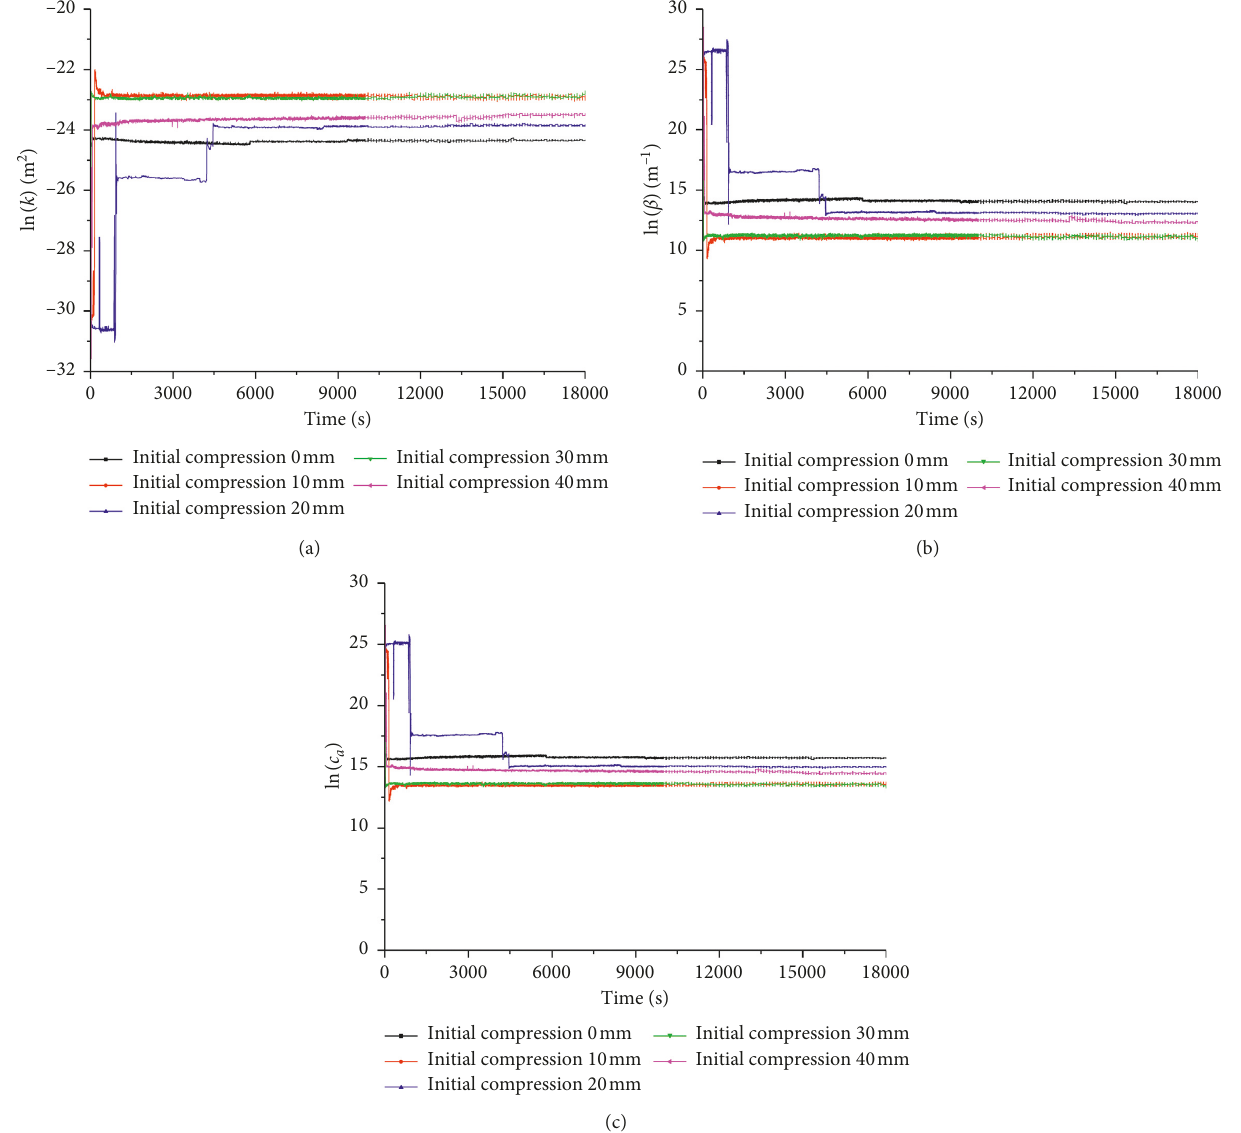
Figure 11: The permeability parameters characteristics in time. (a) Permeability, (b) non-Darcy flow β factor, and (c) acceleration